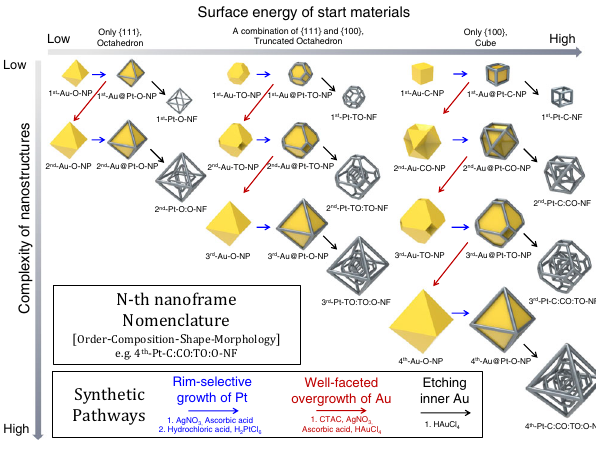
Fig. 1 | Schematic illustration of multi-step synthetic pathway for N-th nano- frames. Three distinctive synthetic pathways including rim-selective growth of Pt (bluearrow),well-facetedovergrowthofAu(redarrow)andetchinginnerAu(black arrow) are represented, and the nomenclature for N-th nanoframes is